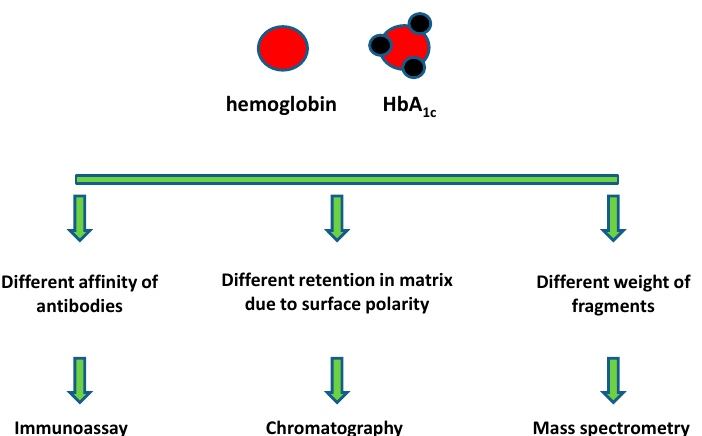
Figure 2. General principle of HbA 1c assay in the presence of standard hemoglobin.